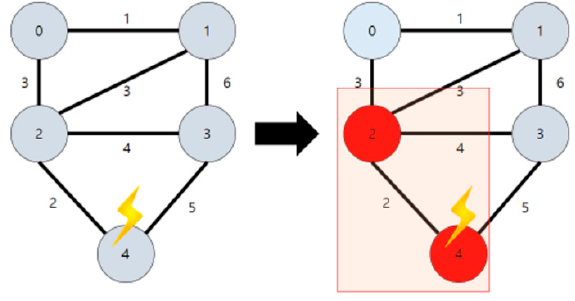
Figure 10. Proposed Algorithm (2).